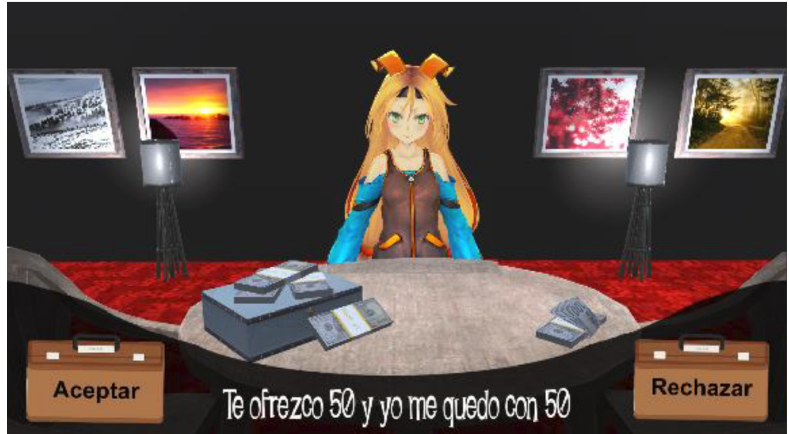
Figure 1. An avatar offers a 50–50 split to the participant, who plays as a